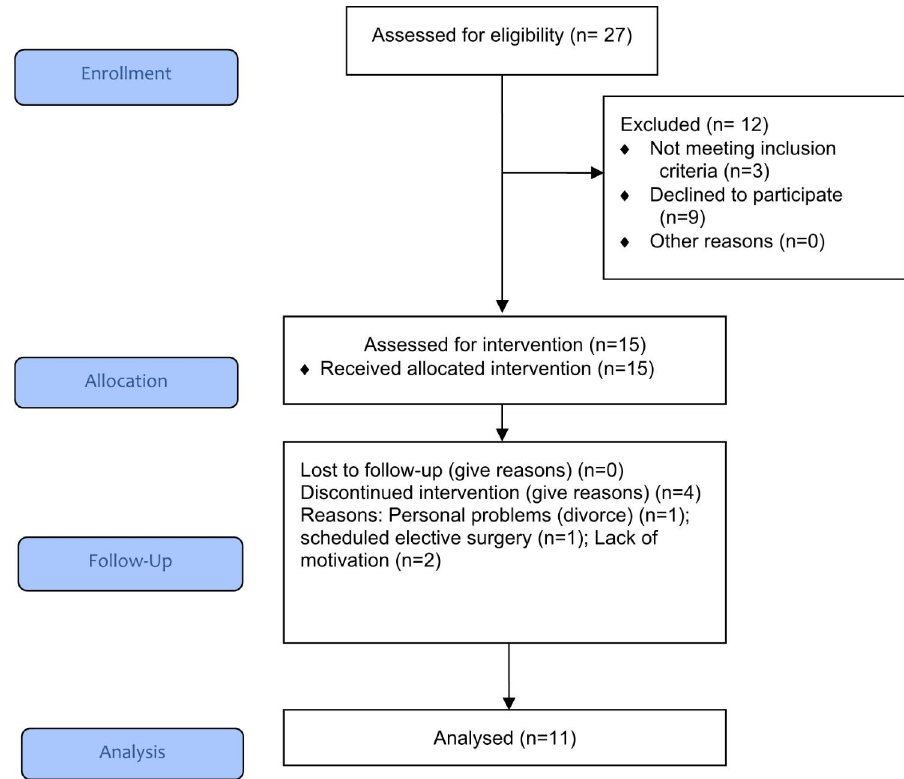
(VIII) Inability to feel = 3.0 to 1.1 points; (IX) Pessimistic thoughts = 1.8 to 0.9 points; (X) Suicidal thoughts = 0.8